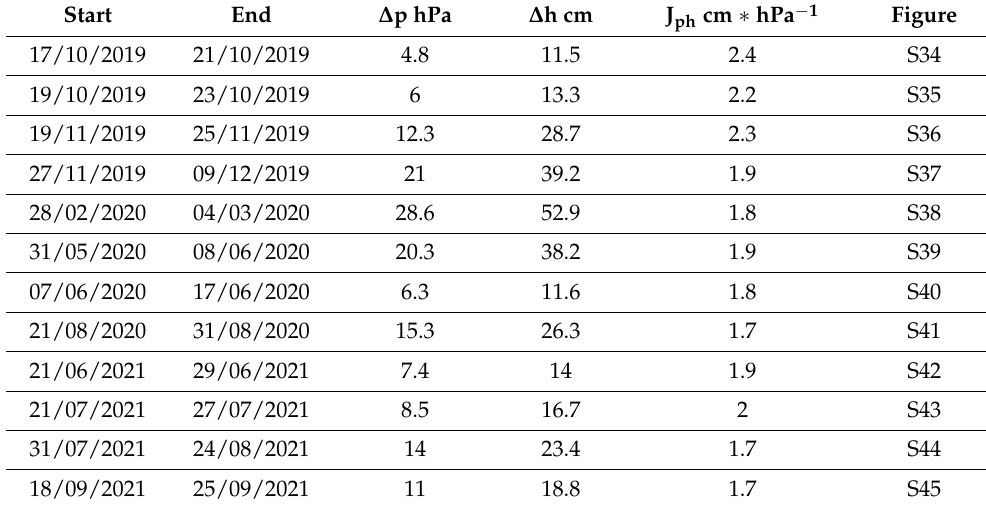
Table A2. Estimated values for representative events occurred from 2006 to 2021 in the port of La Spezia.